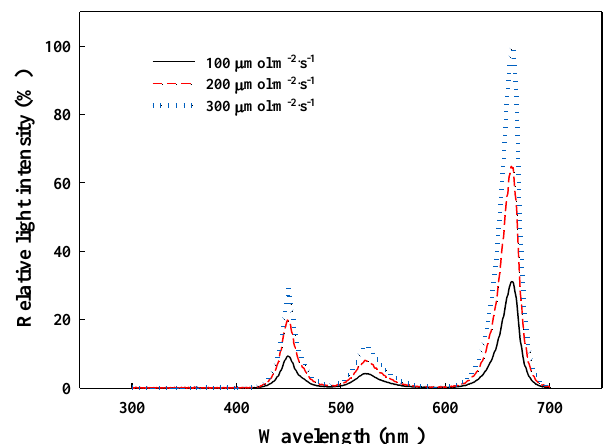
Figure 8. Relative spectral distribution of the RGB LEDs (red:green:blue = 7:1:2) used in a closed-type plant production system.